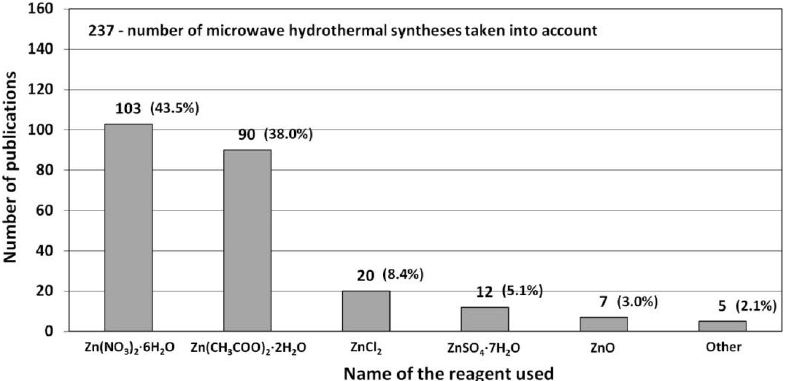
Figure 15. Statistics concerning the use of reactants (Zn 2 + salts) in the microwave hydrothermal synthesis of ZnO. Source: [506–738].